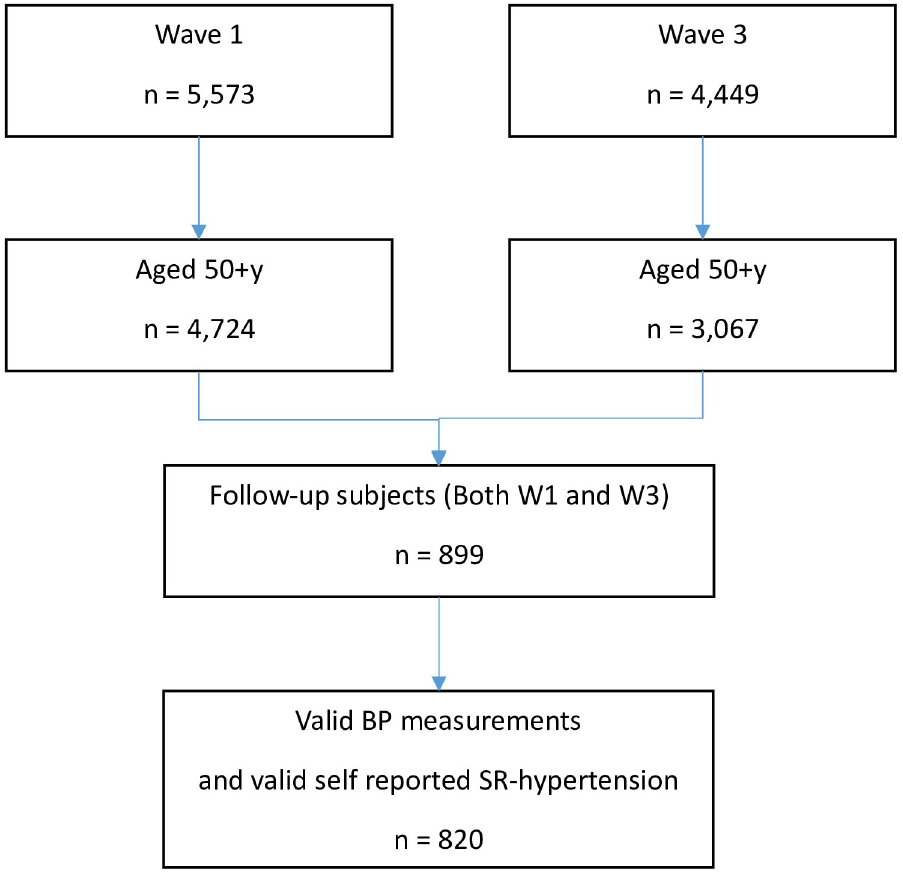
Fig 1. Flow diagram of recruitment and inclusion